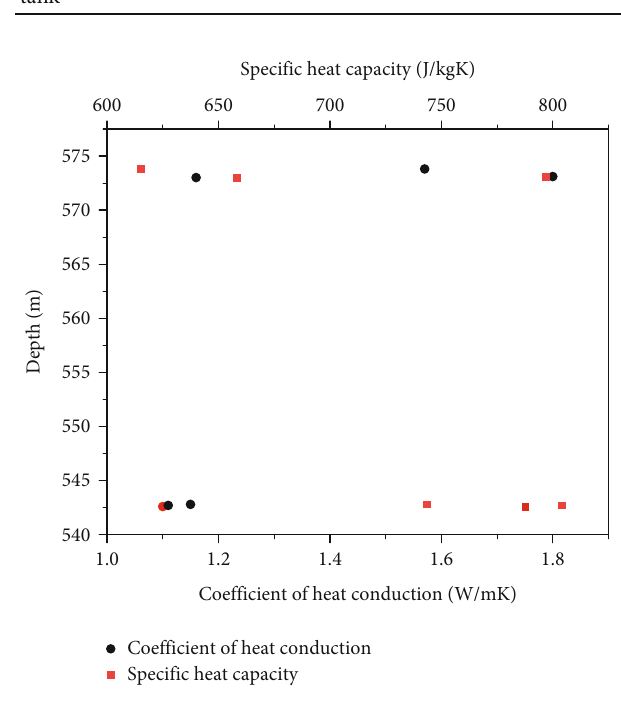
Figure 6: Thermal conductivity test